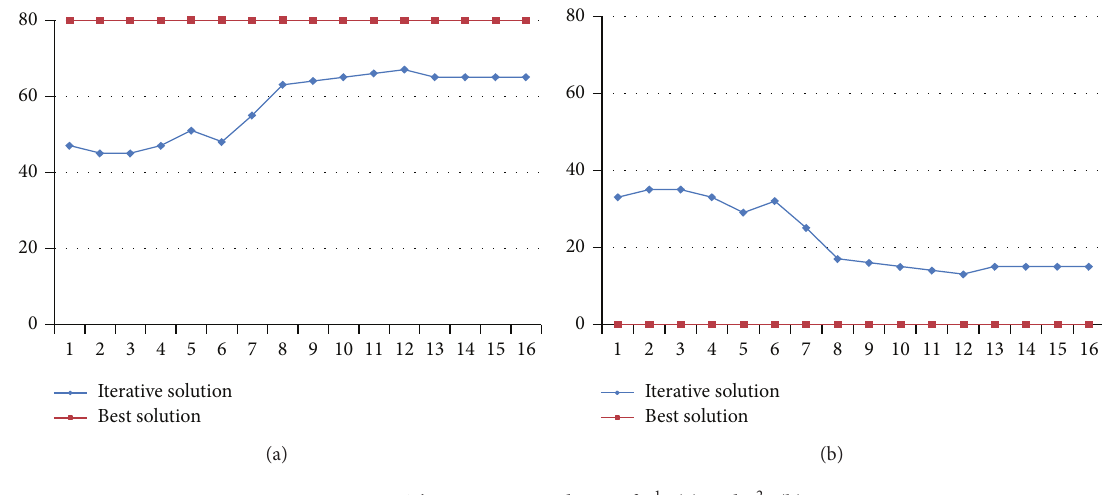
Figure 6: The variation tendency of 𝑥 1 34 (a) and 𝑥 2 34 (b).